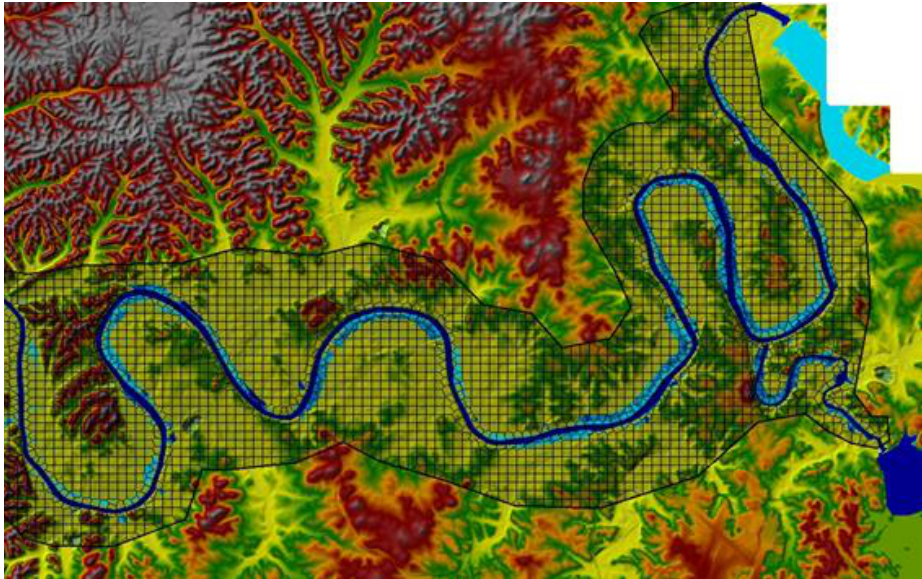
Figure 11. Optimized flooding (inundation areas in blue) using the two-dimensional approach in the optimization/simulation model for the May 2010 flood event.